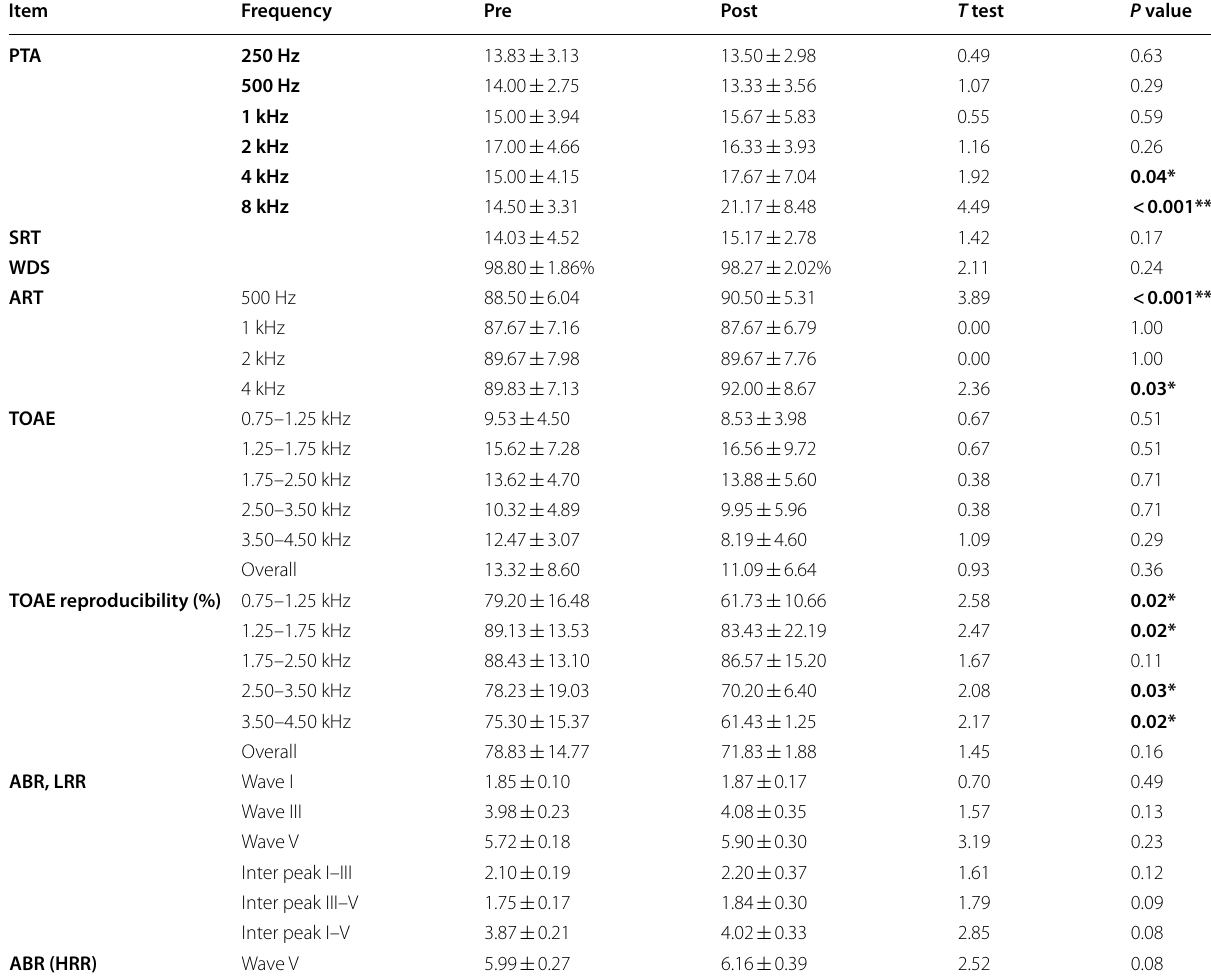
There were statistically significant differences between the two measures regarding PTA, AR, and TEOAE